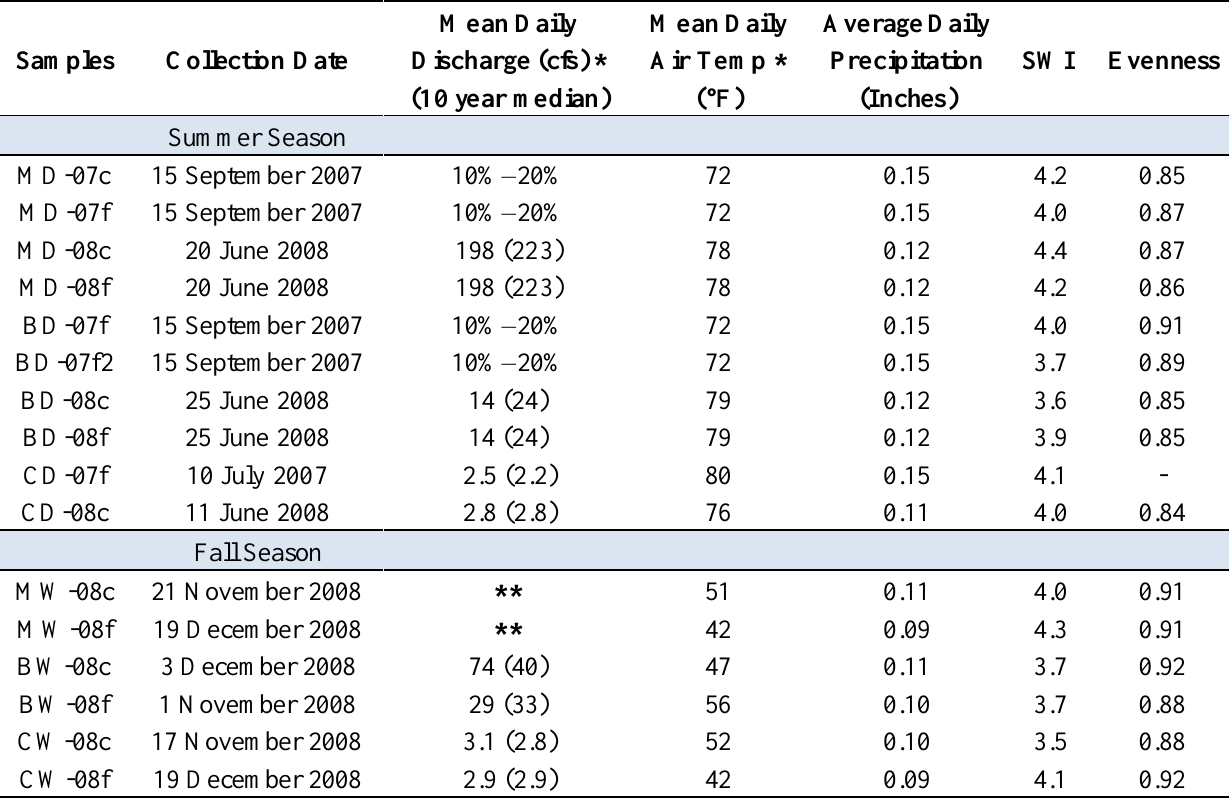
Table 1. Sample identification numbers, collection dates and ambient water parameters for the three sampling sites are listed. Naming convention: The first letter signifies stream site; M = Marks Creek, B = Bear Creek, C = Crabtree Creek. Second letter signifies seasonal period in which collected; D = dry, W = wet. Numeric code is the year of collection. Lower case letters depict sediment size; c= coarse; f = fine. SWI and Evenness correspond to Shannon Weaver indices for sediment bacterial